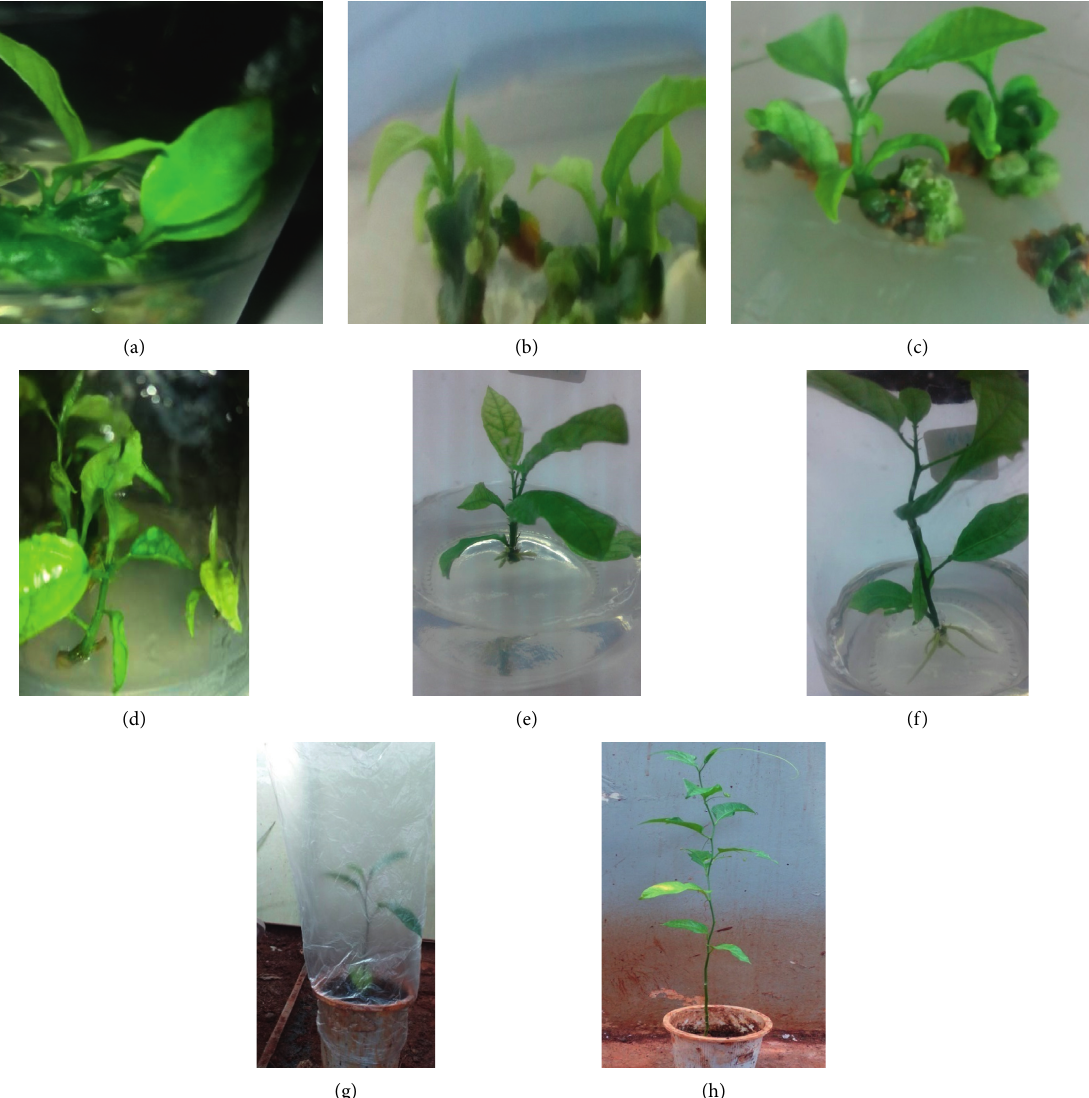
Figure 1: In vitro regeneration of plantlets from leaf disc explants of passion fruit variety KPF 4 cultured on MS medium and acclimatization. (a) and (b) Initiation of shoots from leaf disc explants cultured on MS+2mg · L − 1 BAP on the 3 rd and 4 th weeks after culture, respectively; (c) and (d) further development of shoots on MS+0.1mg · L − 1 BAP on the 2 nd and 4 th weeks after culture, respectively; (e) and (f) rooted plants on MS+0.1mg · L − 1 NAA on the 1 st and 2 nd weeks after culture, respectively; (g) acclimatization stage (2-week- old plant in a plastic pot); (h) one- month-old acclimatized plant in a plastic